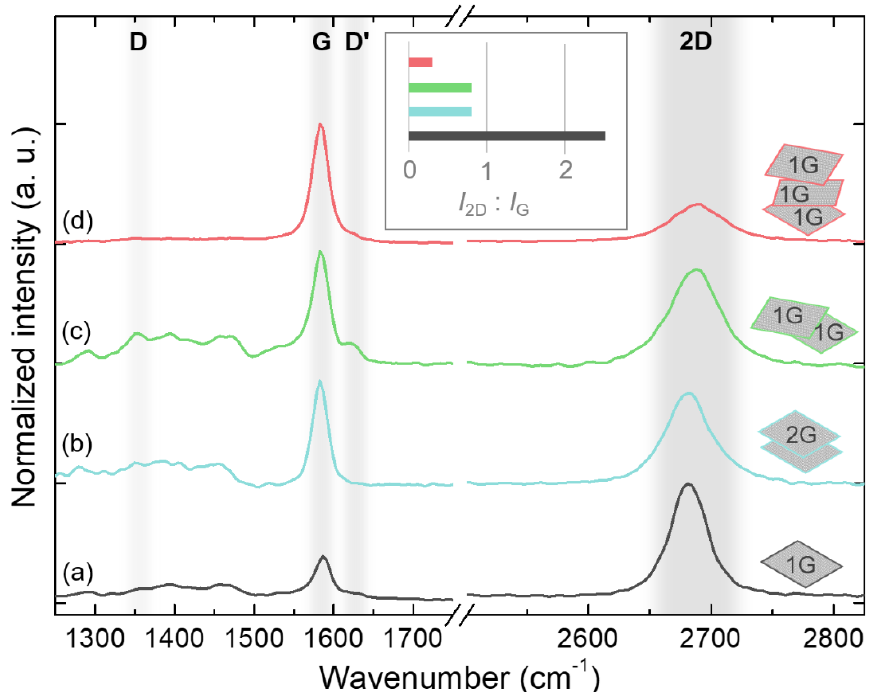
Figure 2. Raman spectra measured after the transfer of monolayer graphene (a), bilayer graphene (b), double-stack of monolayer graphene (c), and triple-stack of monolayer graphene (d). The spectra are normalized and shifted vertically for clarity. The approximate positions of the graphene Raman modes: D, D’, G, and 2D are highlighted. Inset illustrates the ratio of 2D and G mode intensities for corresponding layers.